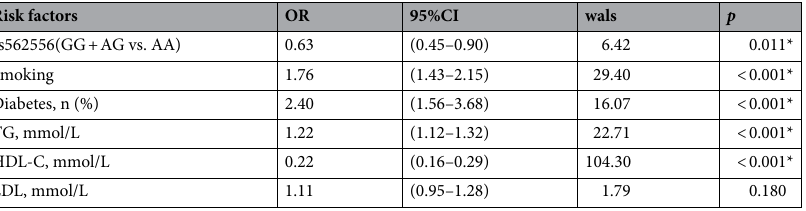
Table 4. Multiple logistic regression analysis for CAD patients and control subjects. Adjust: smoking, diabetes, TG, HDL-C, and LDL-C. TG triglyceride, LDL-C low density lipoprotein-cholesterol, HDL-C high density lipoprotein-cholesterol. * p -values < 0.05.